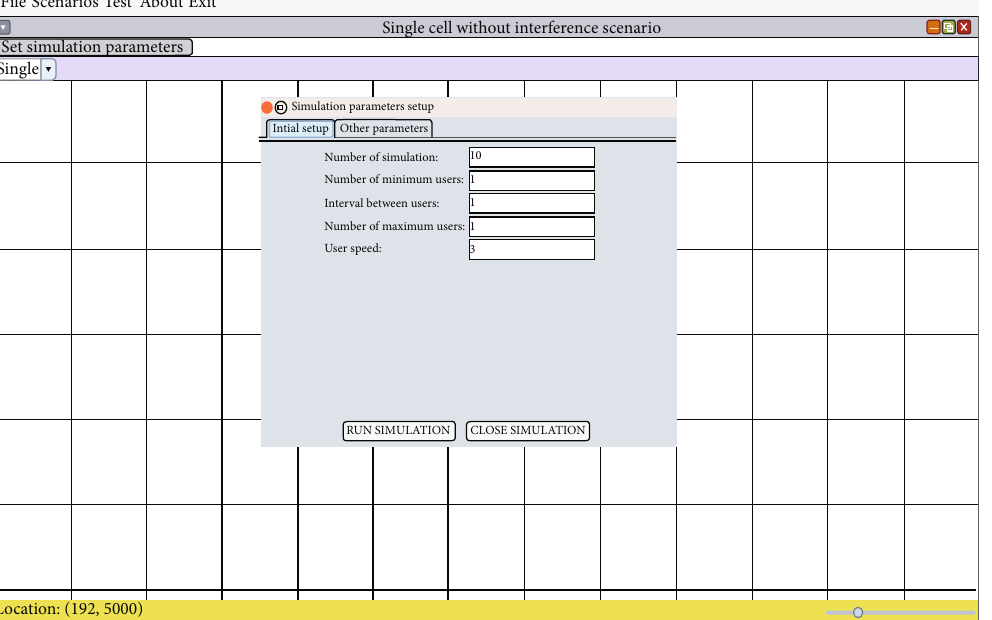
Figure 7: Initial simulation setup parameters.